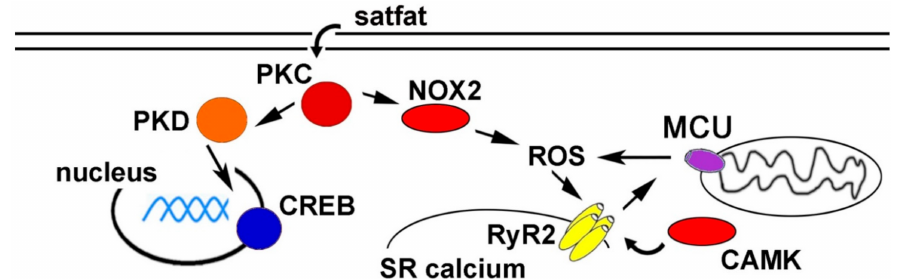
Figure 1. Schematic of proposed pathways promoting arrhythmia during high fat diet (HFD) and / or obesity. CAMK = calcium / calmodulin-dependent protein kinase, CREB = cAMP response element-binding protein, MCU = mitochondrial calcium uniporter, NOX2 = NADPH oxidase 2, PKC = protein kinase C, PKD = protein kinase D, ROS = reactive oxygen species, RyR2 = ryanodine receptor 2, SR = sarcoplasmic